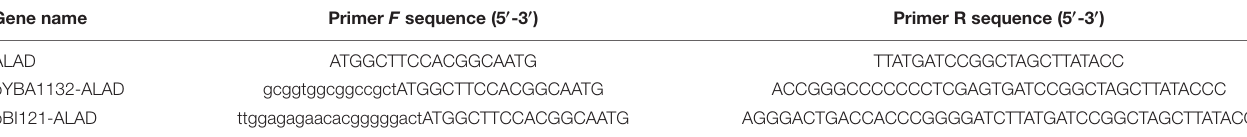
TABLE 1 | Primers used for PCR.